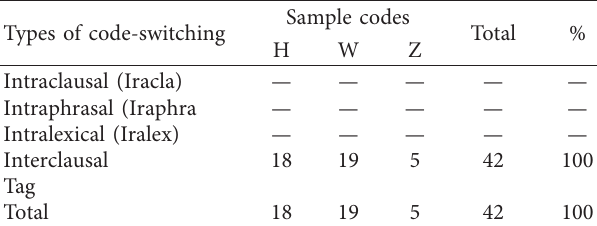
Table 6: The types of English-Indonesian code-switching. Types of code-switching